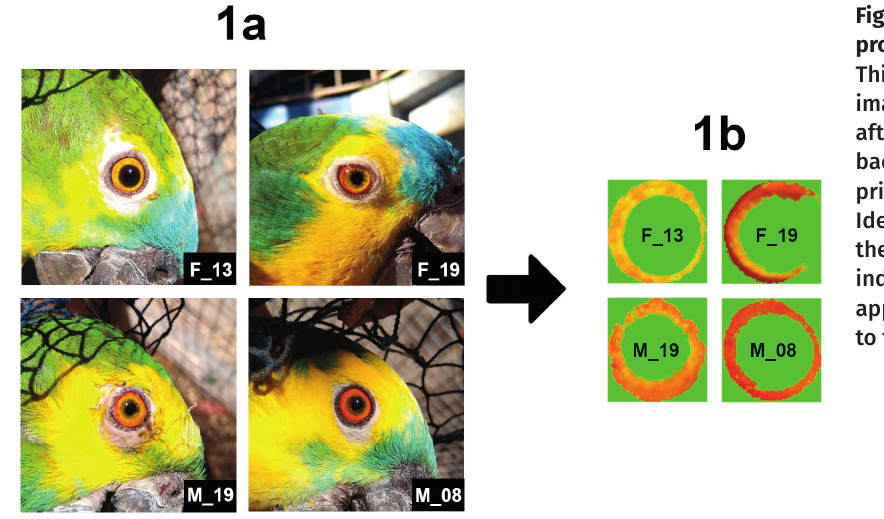
Figure 1. Photographs processing prior